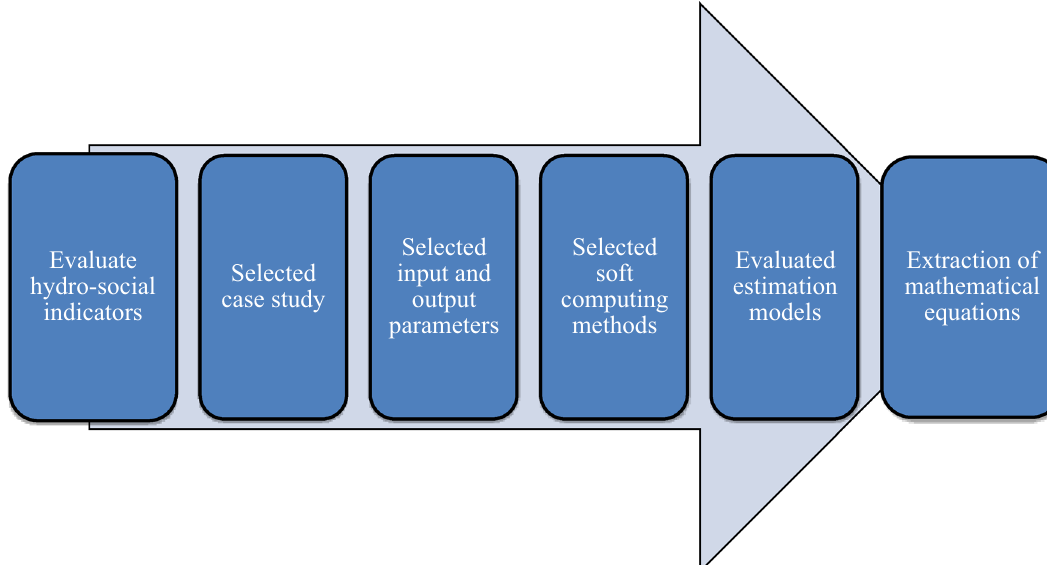
Figure 1. The phases of this work’s methodology.